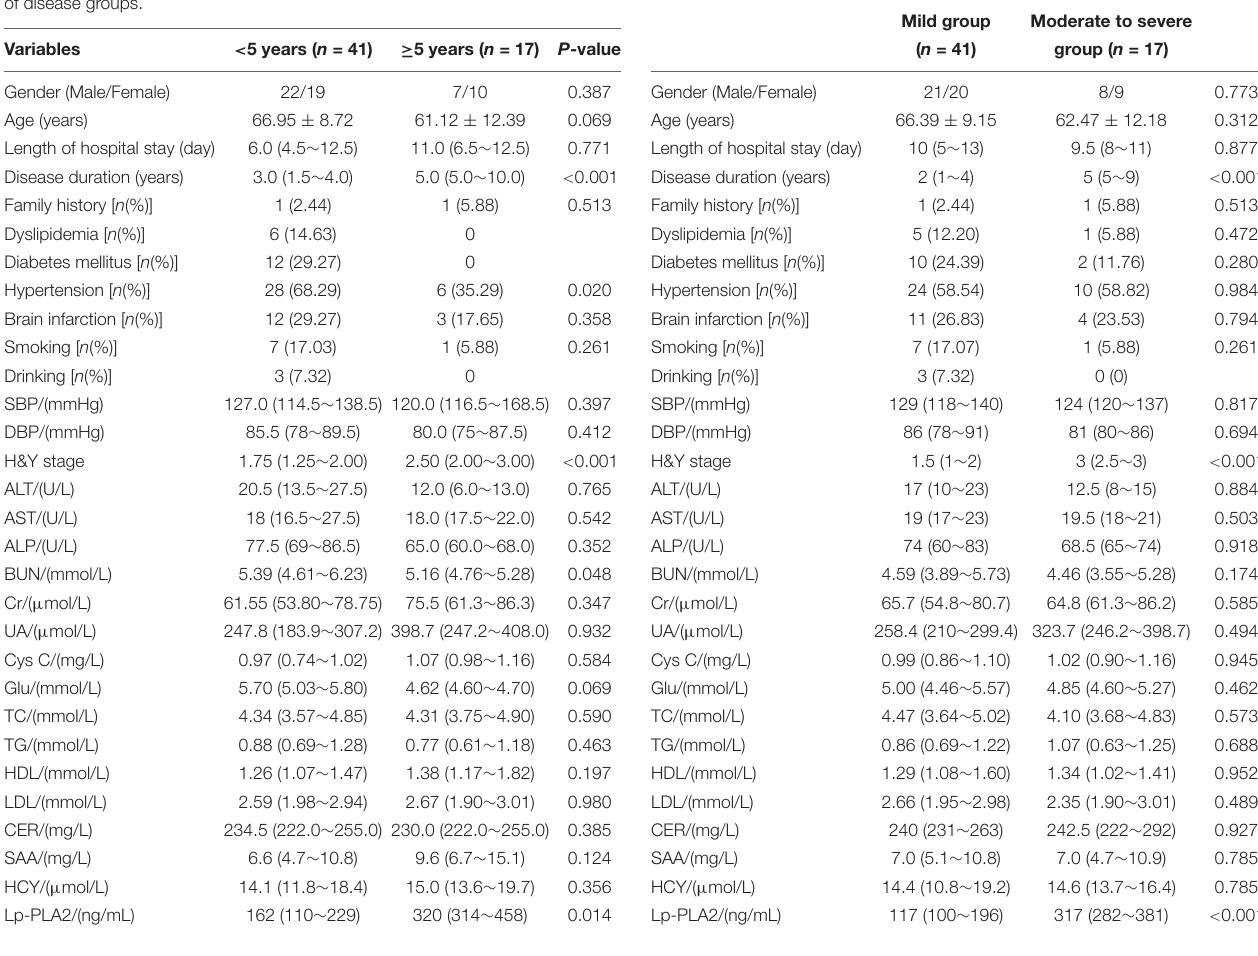
TABLE 2 | Analysis of general data of PD patients in different course of disease groups.